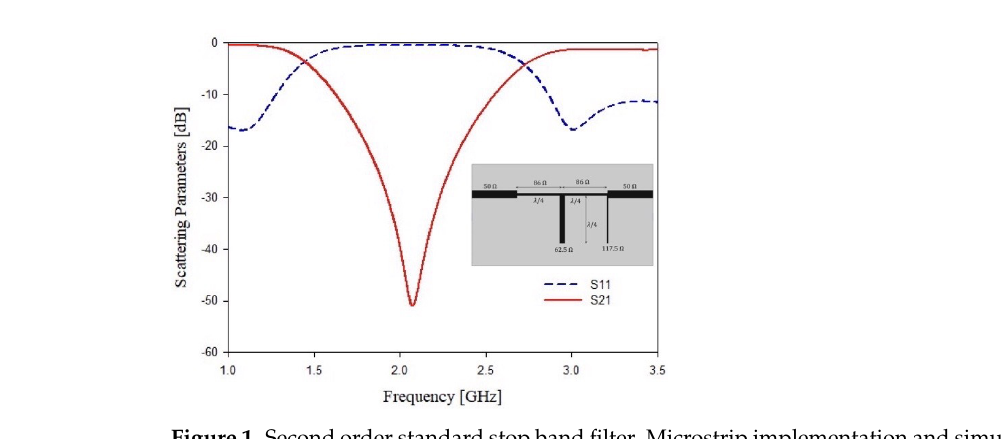
Figure 1. Second order standard stop band filter. Microstrip implementation and simulated scattering parameters S 11 and S 21 .